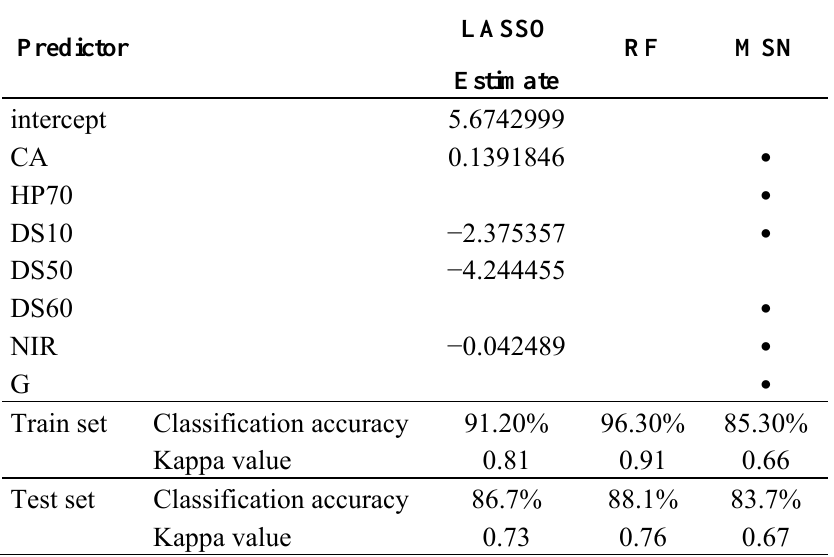
Table 3. Selected features and parameter estimates for LASSO and MSN. Classification accuracies and kappa values for LASSO, RF and MSN are presented under the selected features. Table 2 describes the